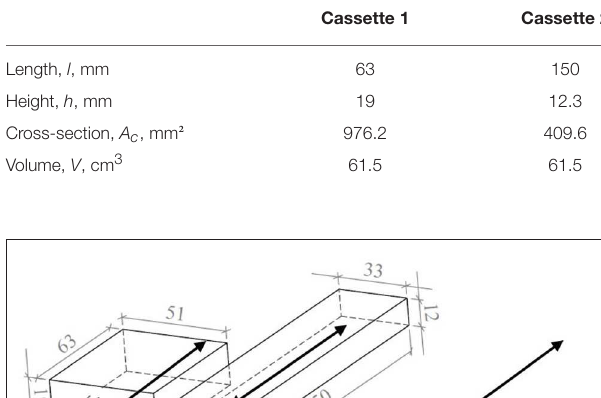
TABLE 1 | Geometric characteristics of the modeled cassettes.